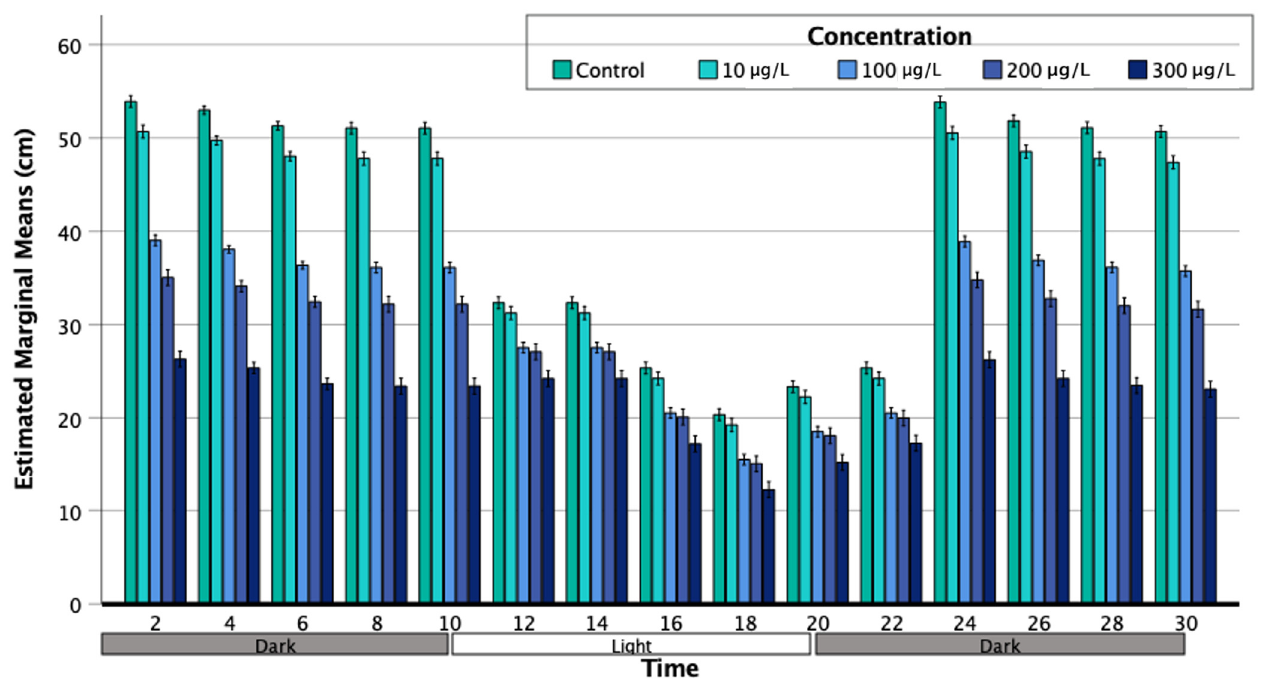
Figure 3. Motor response of zebrafish larvae at 6 dpf is strongly impaired by 2,6-DCBQ-OH. Locomotor activity of control larvae at 6 days post-fertilization ( n = 79), after exposure to 10 μ g/L ( n = 65), 100 mg/L ( n = 100), 200 μ g/L ( n = 45), and 300 μ g/L ( n = 44), were monitored in a 30 min period of dark/light cycling (0–10 min, dark; 10–20 min, light [white area]; 20–30 min, dark). The distance was counted at intervals of 2 min and was compared with the control.